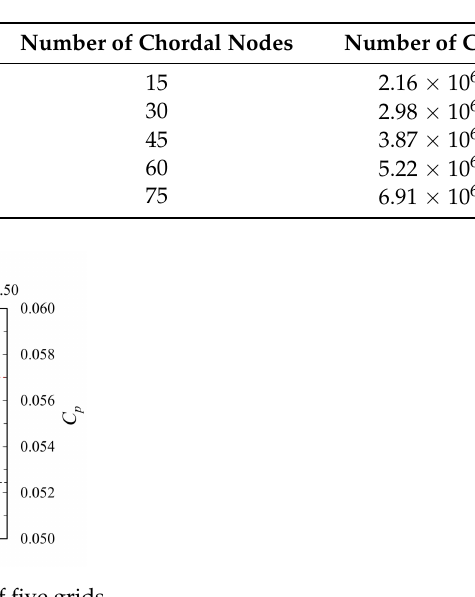
Table 3. Test conditions and parameters of the test model.